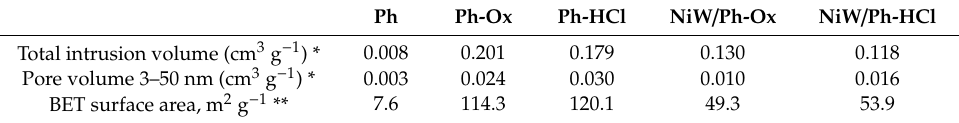
Table 2. Textural properties of the original phonolite material and its derived solids.